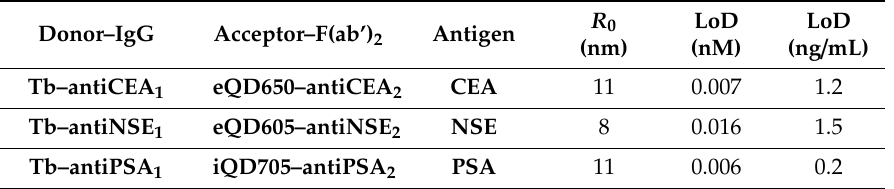
Förster distances and LoDs for the single tumor marker (CEA, nsE, and PSA) FRET